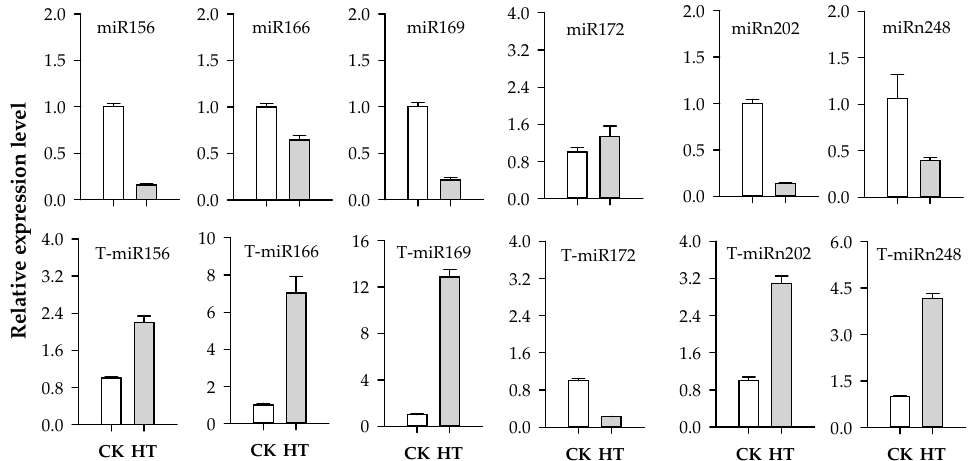
Figure 7. Confirmation by qRT-PCR of miRNAs and target genes identified in sequence data. Bars indicate the standard error of three replications.